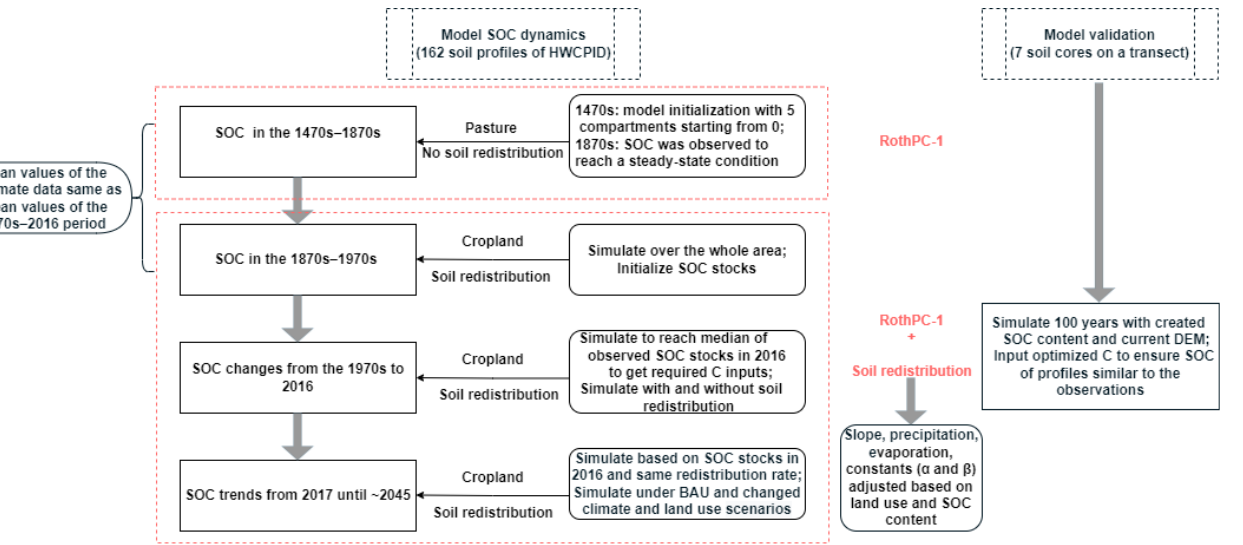
Table 1. Summary of inputs to the coupled model. Category